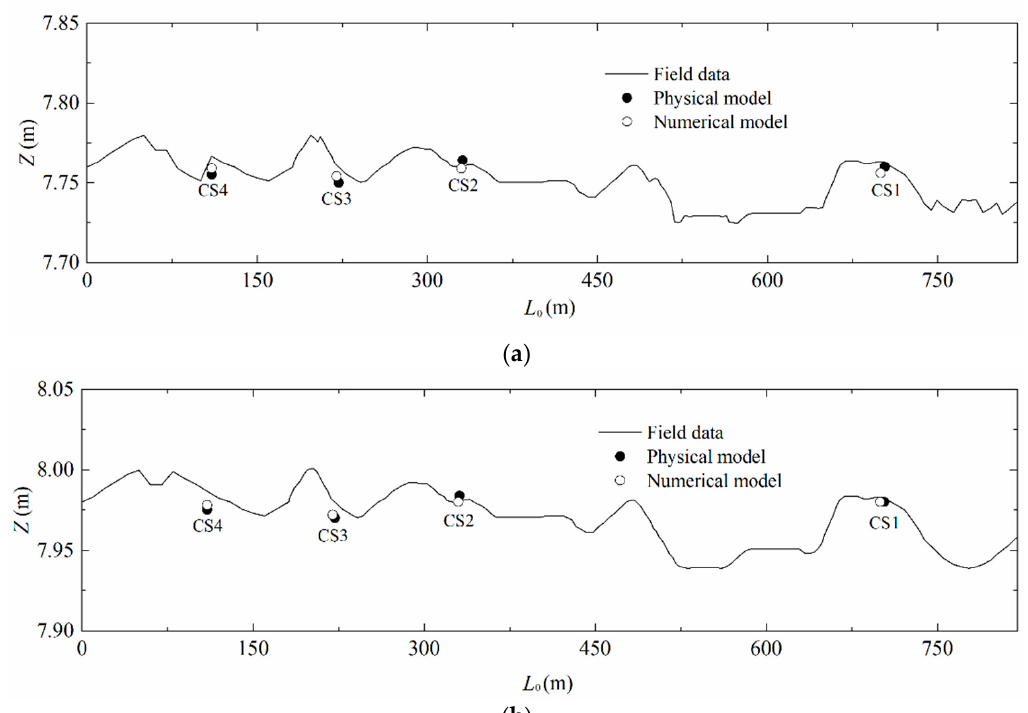
Figure 11 . Prototype Z comparisons among physical model, numerical model, and field data. ( a ) case 1; ( b ) case 2.